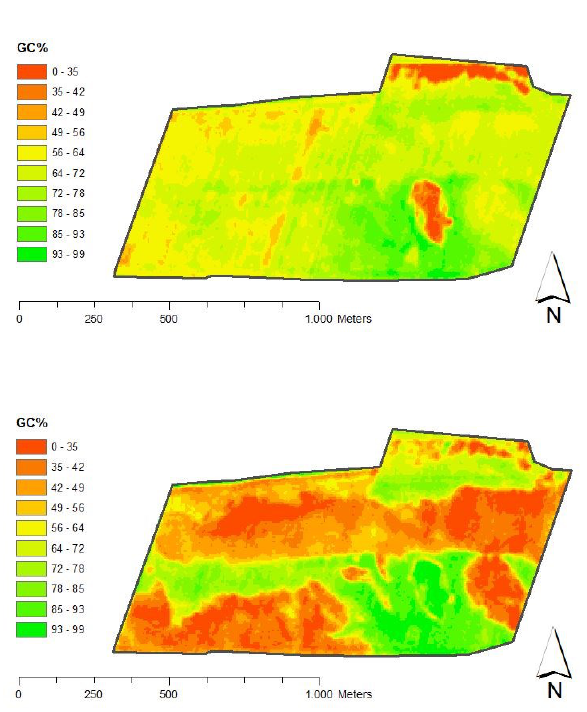
Figure 6. GGC% maps for winter wheat derived from RapidEye imagery acquired on 7 th of May 2011 (top) and on 27 th of June 2011